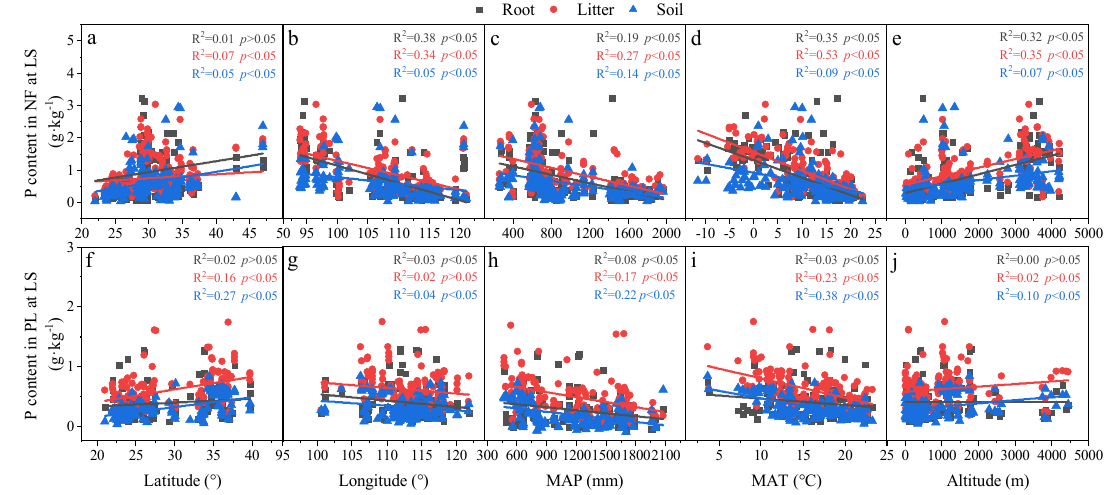
Figure 7. P concentration changes with latitude ( a , f ), longitude ( b , g ), mean annual precipitation (MAP) ( c , h ), mean annual temperature (MAT) ( d , i ) and altitude ( e , j ) in different forest origins in the late stage (LS). The numbers of forest sites are 114 and 144 for NF − LS and PL − LS, respectively.